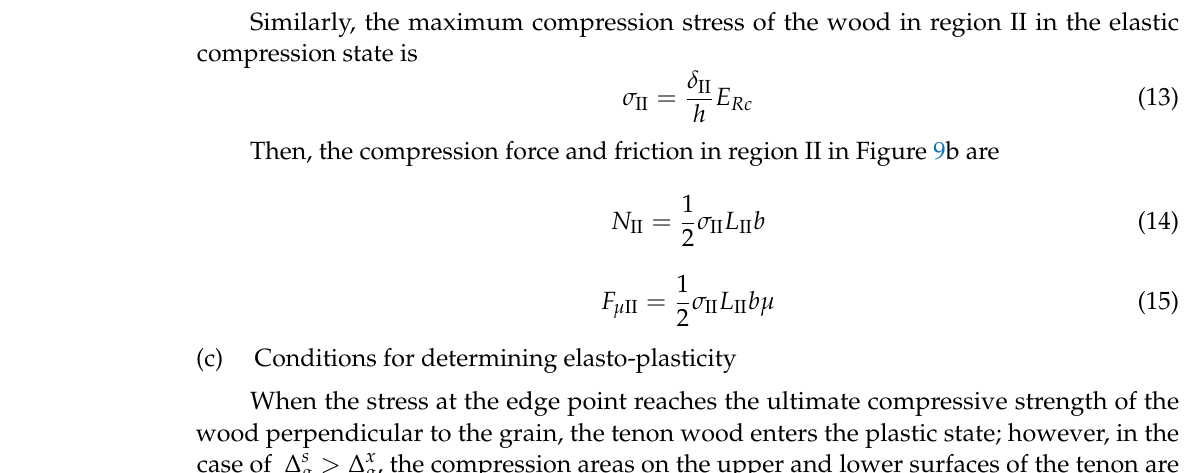
e θ Ι , is obtained by substituting Equation (16) into Equation (18) and inversely solving this by using MATLAB. (2) Condition for determining the plastic state in region II When the stress at the edge point of region II reaches σ cu , the height and length of the compression zone at the edge point are obtained as follows: